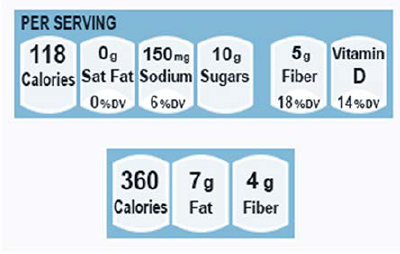
Figure 1. Front of Package (FOP) symbols for cereals ( top ) and frozen entrées ( bottom ). Eye movements were assessed using an EyeLink 1000, which has a sampling rate of 1000 Hz and average accuracy of 0.25–0.5 degree. The eye tracker projects an infrared light onto the participant’s eye, which reflects back to a video camera that records time and eye-position coordinates. The task began with a nine-point calibration task followed by two practice